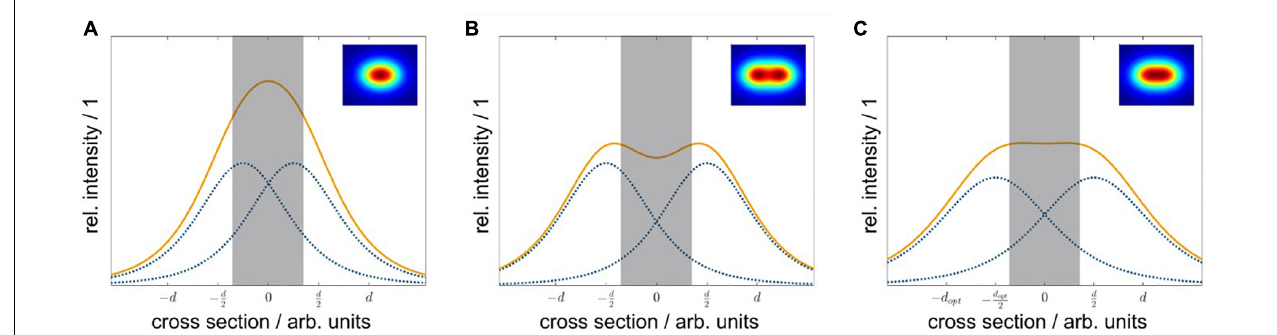
FIGURE 9 | Side-view of the irradiance distribution depending on the LED distance. Depending on the LED distance d , the resulting irradiance from the two overlapping LED irradiance distributions at the sample plane differs. Individual LED irradiance distributions are represented as dotted lines (blue), and the resulting distributions are shown as solid lines (orange) the gray bar indicates the maximum width of the sample plate. If the LED distance d is too low, the overlap in the center is high, and the resulting irradiance is enhanced (A) . For a too large LED distance d , the overlap is small, and the resulting irradiance is reduced (B) . Using the optimal LED distance d opt , each LED contributes the right amount and the resulting irradiance in the center is constant (C) .